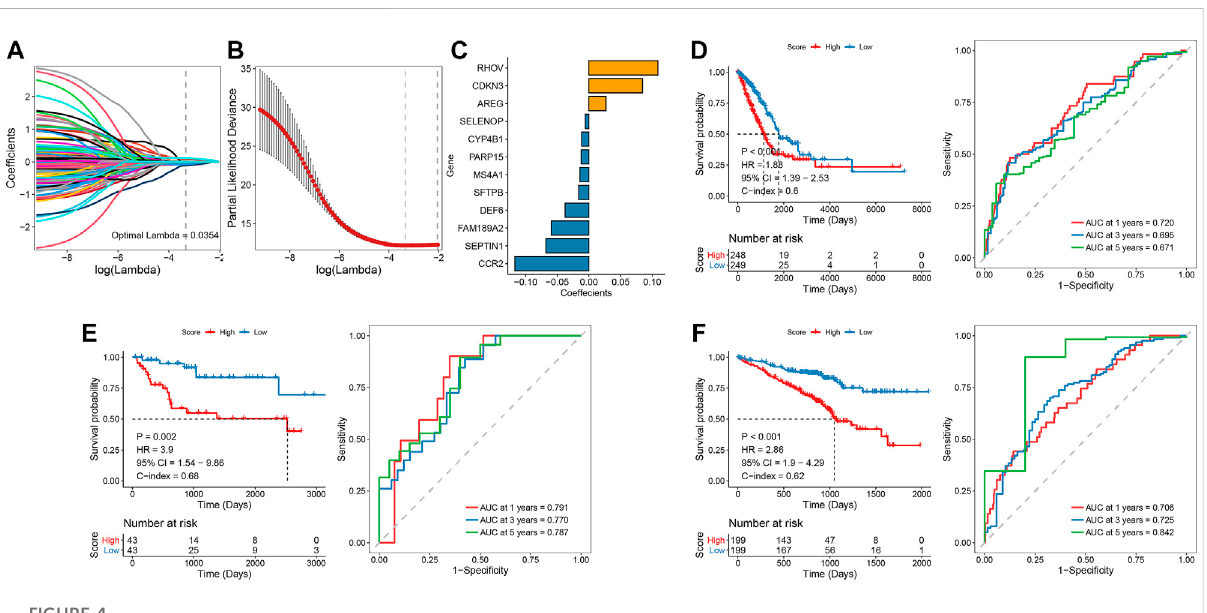
FIGURE 4 LASSO linear regression and univariate Cox analysis screened 12 feature genes associated with prognosis (A-C) ; Survival curve and ROC curve between the high-risk and low-risk groups, veri fi ed by E and F validation sets (D-F)